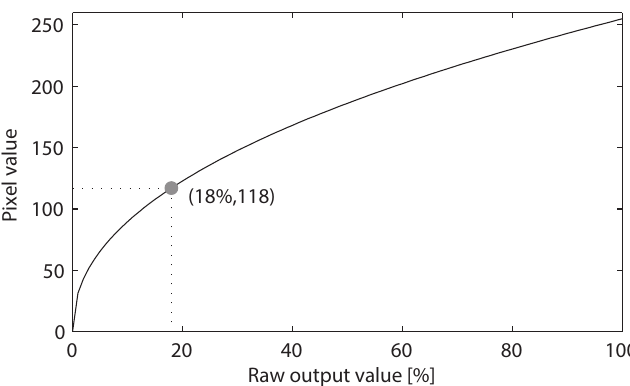
Figure 4. Gamma encoding of raw the pixel value with γ =